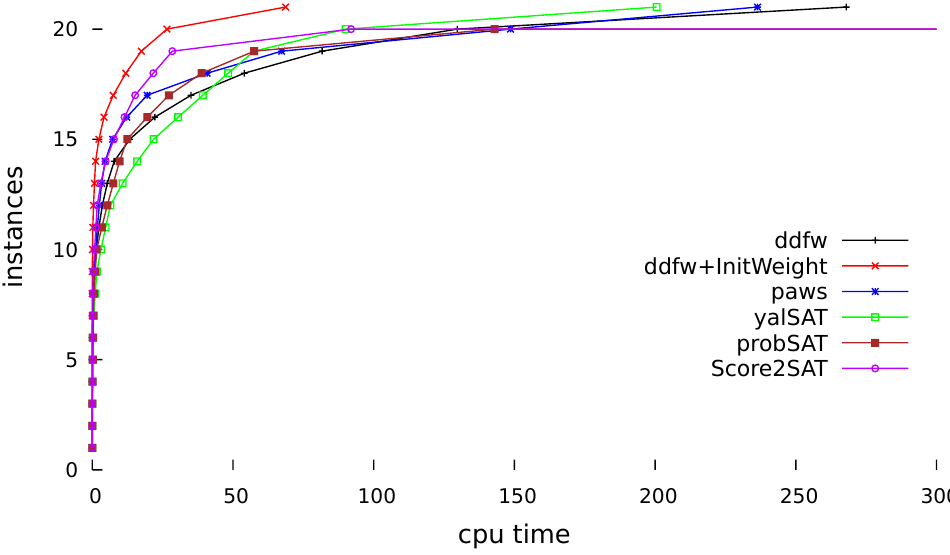
Figure 3. The figure shows the ddfw+initWeight algorithm performance in comparison with other state-of-the-art